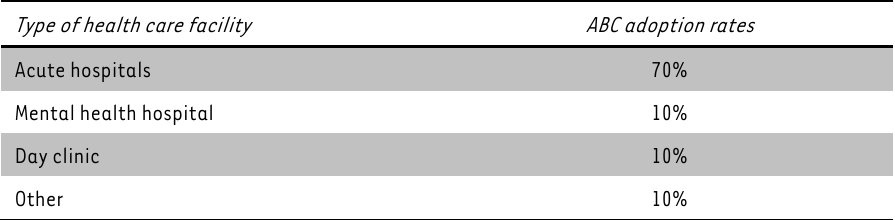
Breakdown of the different types of health care facilities that have adopted ABC Type of health care facility ABC adoption